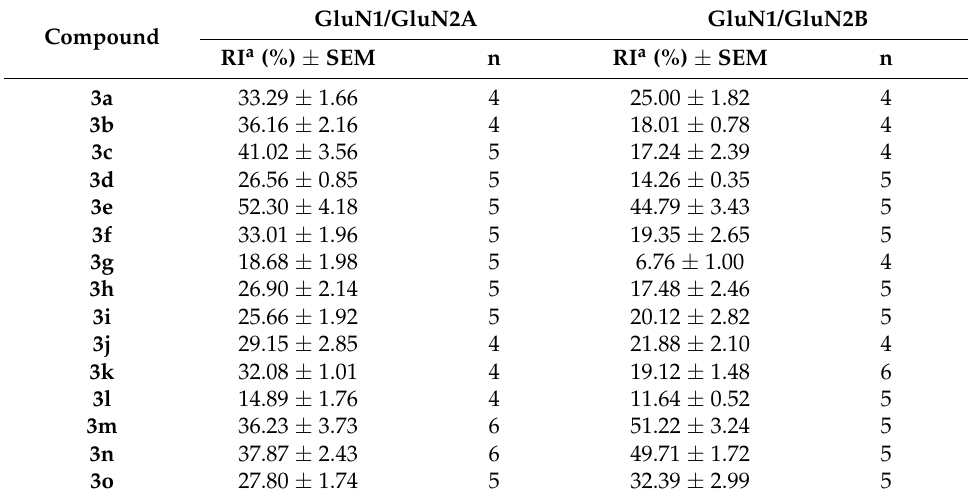
Table 3. The inhibitory effect of the derivatives 3a – o at the GluN1/GluN2A and GluN1/GluN2B